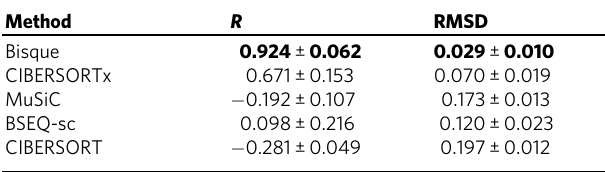
Table 3 Leave-one-out cross-validation in dorsolateral prefrontal cortex using 8 samples with snRNA-seq and bulk RNA-seq data